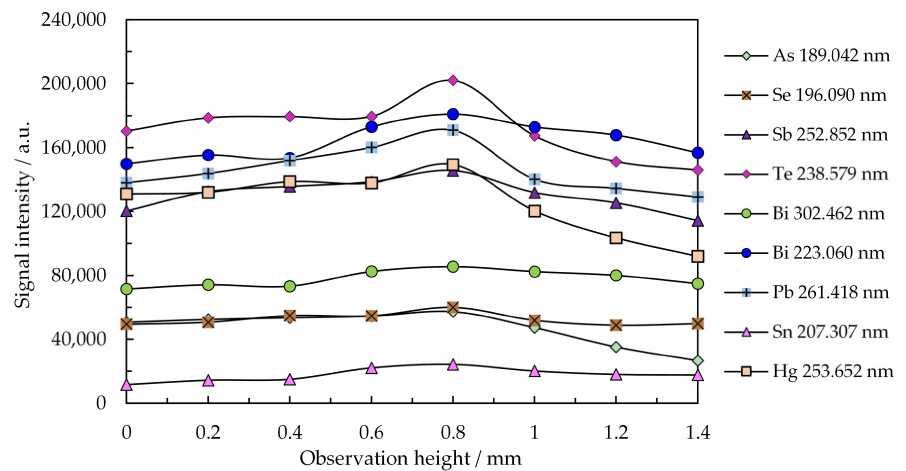
Figure 5. Influence of the observation height in plasma on the emission of the most sensitive lines of As, Bi, Sb, Se, Te, Hg, Pb, and Sn registered with the Maya2000 Pro microspectrometer. Conditions: plasma power: 15 W; Ar flow rate: 150 mL min − 1 ; observation height: 0.8 mm above the electrode tip; sample:10 µ L containing 3 µ g mL − 1 As, Bi, Se, Te, and Sn; 1 µ g mL − 1 Pb and Sb; and 0.2 µ g mL − 1